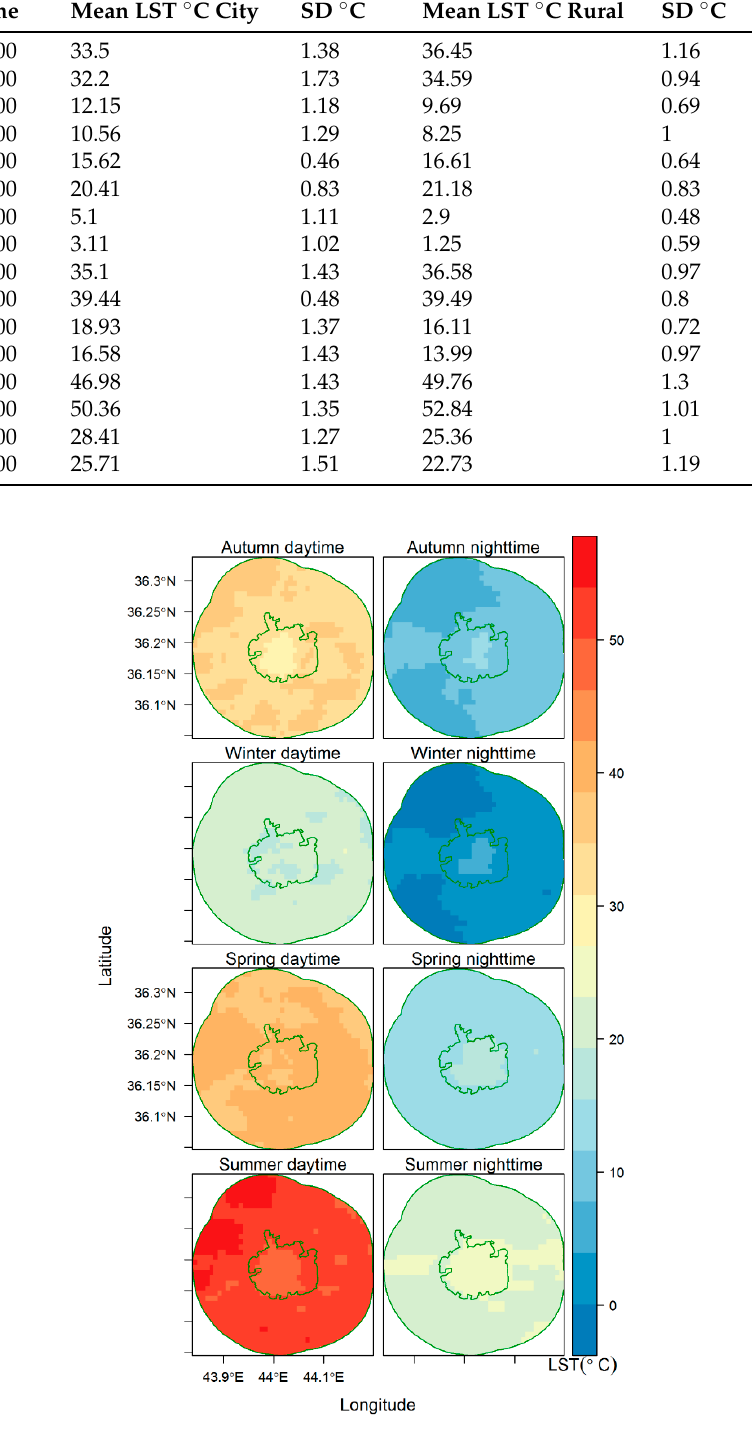
Figure 5. Seasonal variation of average Land Surface Temperature over 12 years, based on MODIS Aqua, the green line is the boundary of Erbil city.